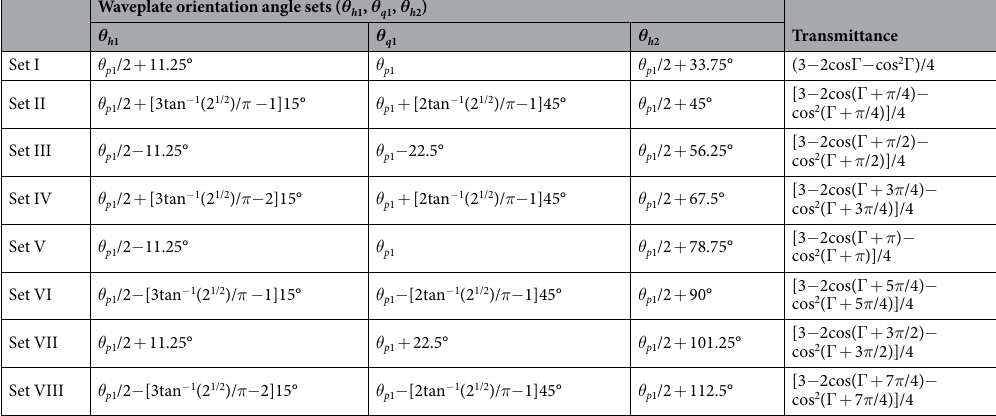
The point ( θ h 1 , θ q 1 , θ h 2 ) on the helical locus in Fig. 2(c), whose projection on the θ h 1 − θ q 1 plane is equal to the locus in Fig. 2(b), also moves from bottom to top with increasing φ . These plain and deterministic locus patterns can facilitate the prediction of the waveplate angles for the continuous wavelength tuning of filter spectra. Figure 2(d) shows the periodicity of the waveplate angle loci of ( θ h 1 , θ q 1 ) for the continuous tuning for two = 30°, respectively. Open (white) symbols (circles and squares) in these loci indicate starting points of orbits θ p 1 where φ = 0°. Each type has a period of 90° and 180° for θ h 1 and θ q 1 , respectively. A dashed rectangle implies the direction. At θ p 1 = 0°, indicated as a red-dashed box, this unit rectangle has four vertices of (0°, − 90°), (90°, − 90°), (90°, 90°), and (0°, 90°). In comparison with the case of θ p 1 = 0°, the unit rectangle at θ p 1 = 30° shifts by 15° and 30° toward + θ h 1 and + θ q 1 axes, respectively. It is clearly seen from Fig. 2 that a waveplate angle set ( θ h 1 , θ q 1 , θ h 2 , θ q 2 ) always exists for φ that increases from 0° to 360° with a step of 1° although there is not necessarily a one-to-one correspondence between ( θ h 1 , θ q 1 , θ h 2 , θ q 2 ) and φ . Even for φ with a finer step < 1°, the same traces are obtained in each figure. This proves that the WPC of the proposed filter enables the continuous wavelength tuning of the